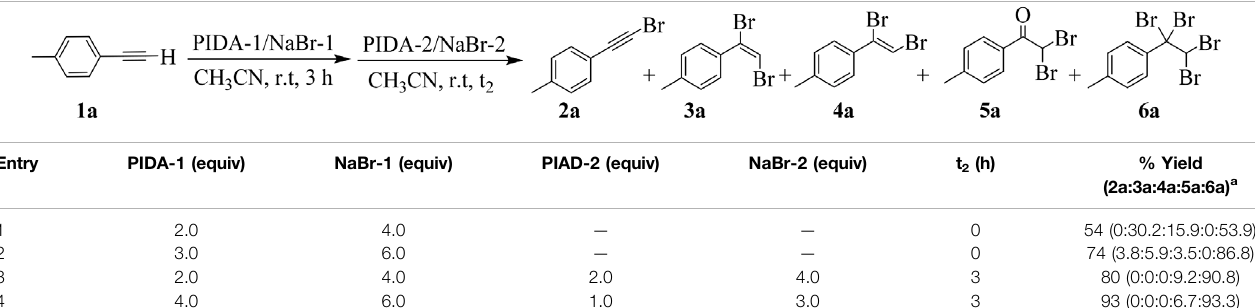
TABLE 2 | One-Pot Bromination of p -Tolylethyne with Hypervalent iodine